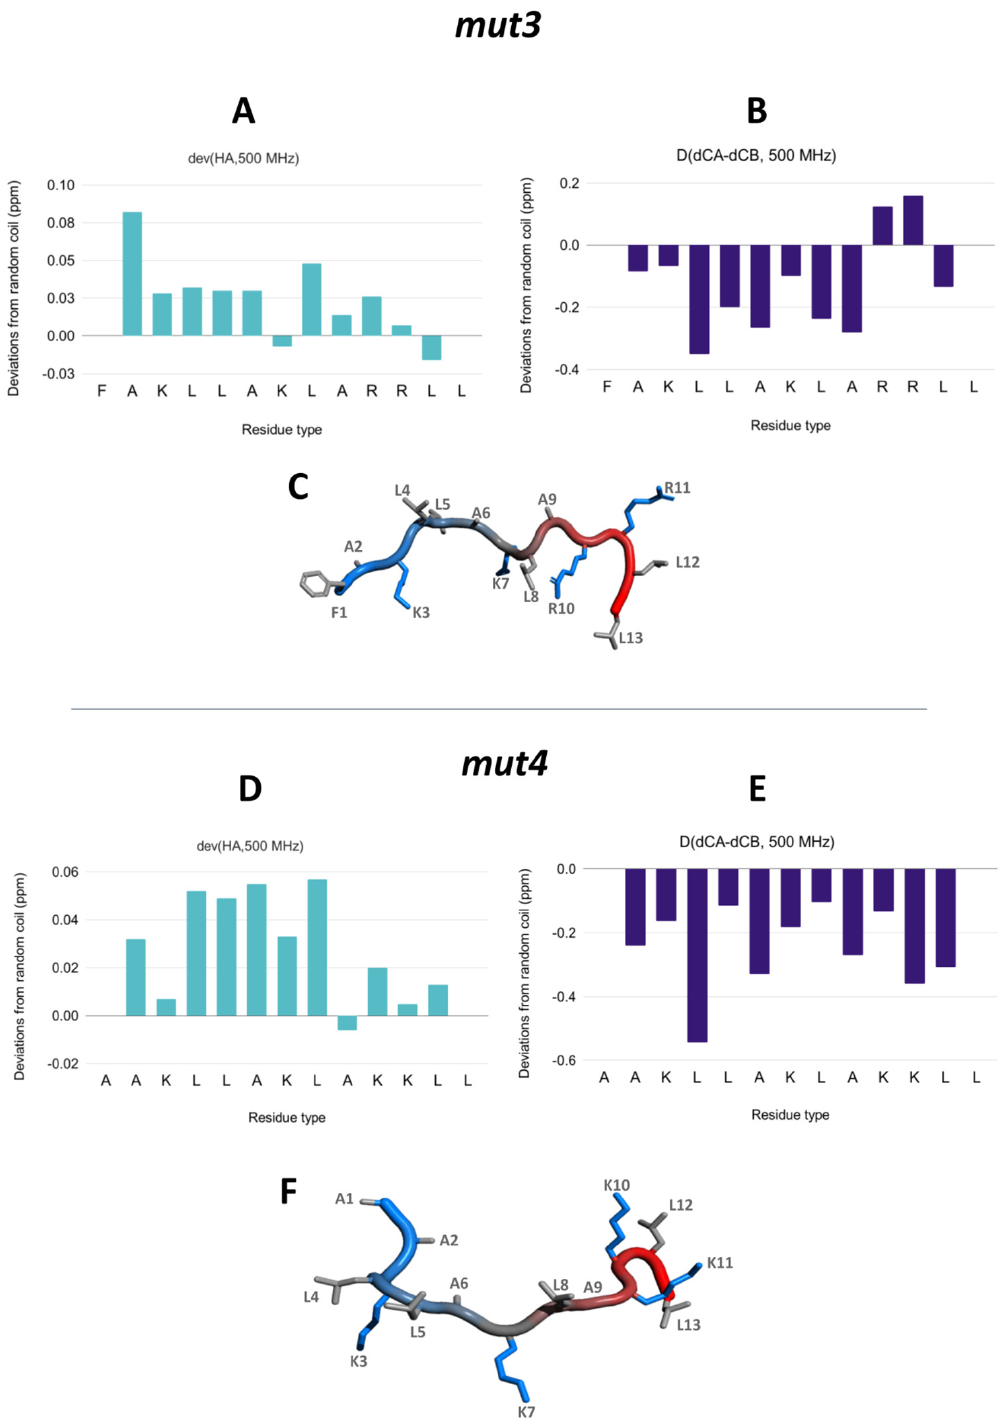
Figure 4. HB43 mutants tend to be unstructured in solution. ( A , B , D , E ) Chemical shift deviations from random coil values of H α protons ( A , D ) and C α –C β carbons ( B , E ) suggest the absence of the structure of mut3 (top) and mut4 (bottom). ( C , F ) Schematic representations of mut3 ( C ) and mut4 ( F ) are shown as a ‘tube’ colored from blue (N-terminus) to red (C-terminus). Sidechains are shown as sticks with the following color code: positively charged (blue) and nonpolar (light gray). The structures were created with PyMol [76]. Data on HB43 peptide were previously published